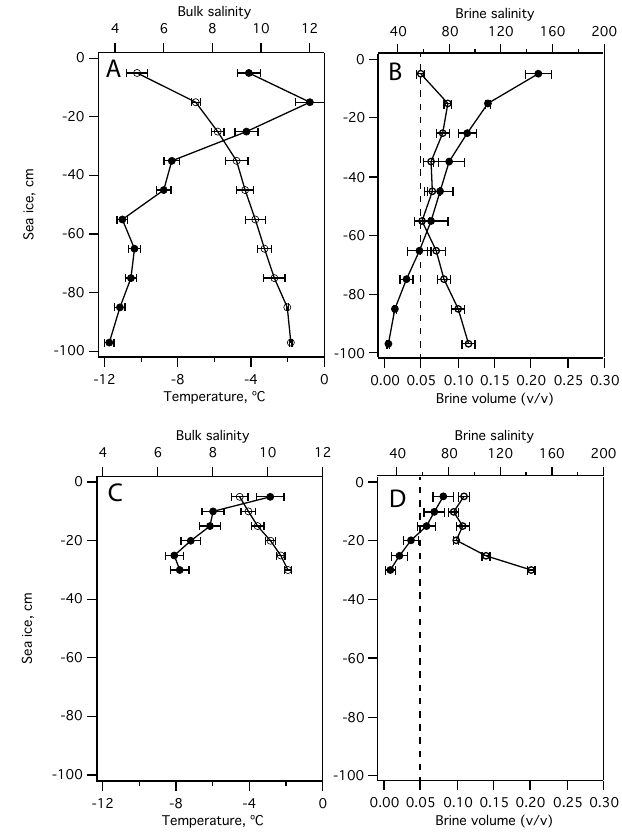
Fig. 2. Vertical profiles of sea ice features. (A) Temperature (-o-) and bulk salinity (- • -) and (B) brine volume (-o-) and brine salin- ity (- • -) at ICE I. (C) Temperature (-o-) and bulk salinity (- • -) and (D) brine volume (-o-) and brine salinity (- • -) at POLY I. Vertical dotted line represents the brine volume where sea ice becomes per-